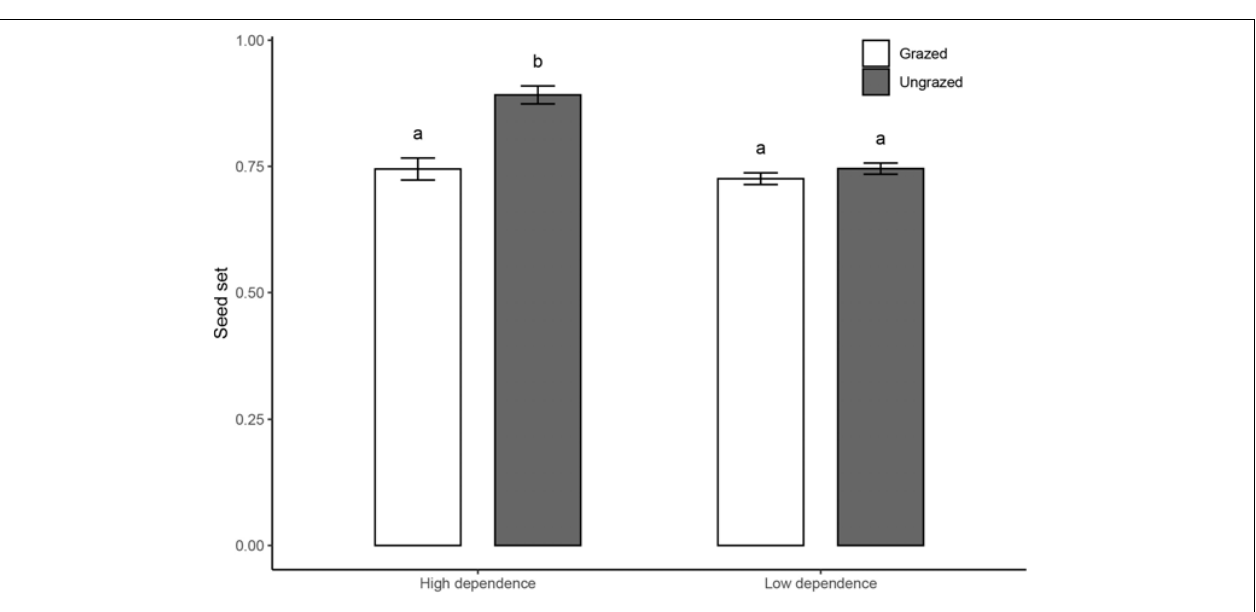
FIGURE 4 | Seed set (mean ± SE) of four high-dependence and 14 low-dependence species in grazed and ungrazed Tibetan alpine meadows. White bars represent grazed habitats, and gray bars represent ungrazed habitats. Letters shown above the bar plots indicate the statistical difference between grazed and ungrazed habitats ( P =